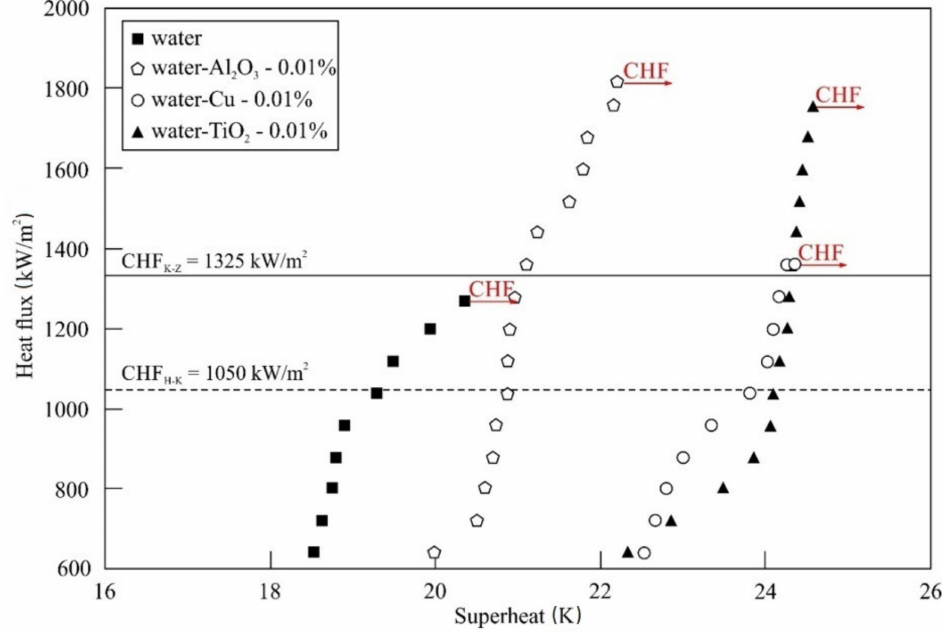
Figure 10. Boiling curves and CHF values for deionized water and water–Al 2 O 3 , water–TiO 2 and water-Cu nanofluids on a stainless steel tube ( D o = 3